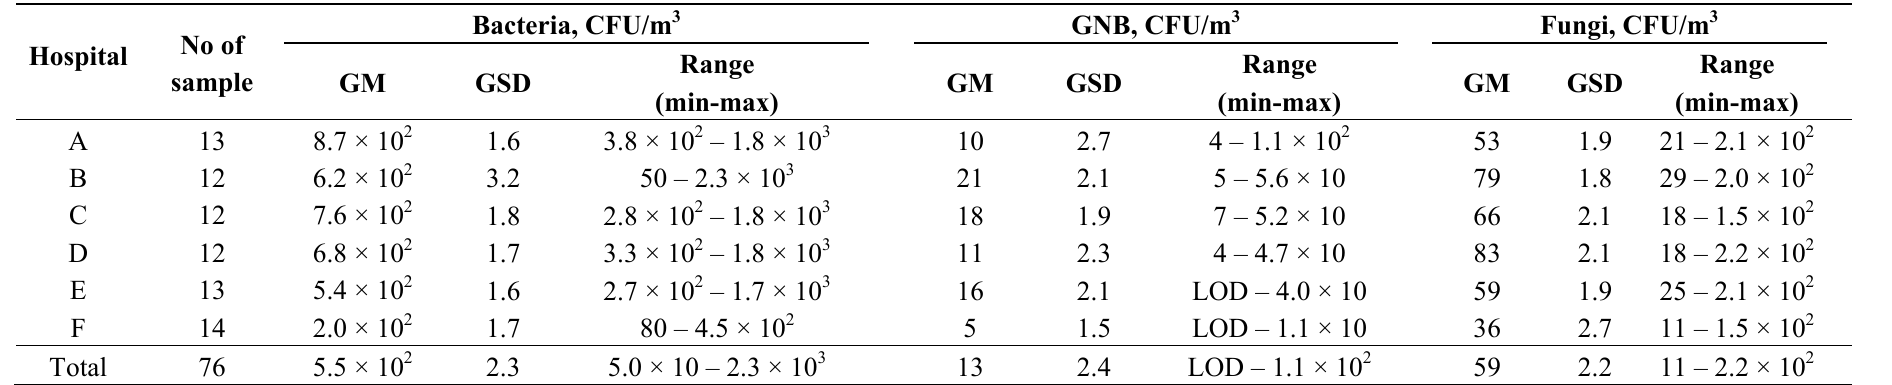
Table 3. Airborne microorganism levels by